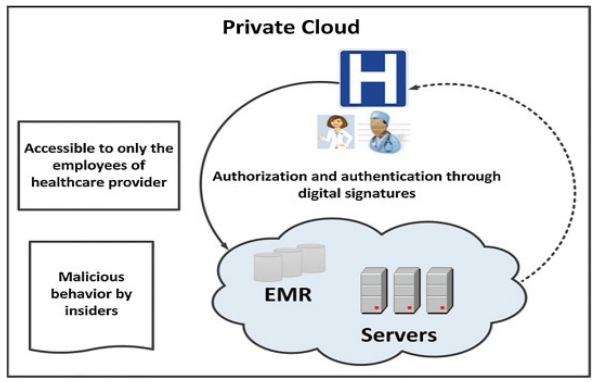
Figure (a). Public e-health cloud